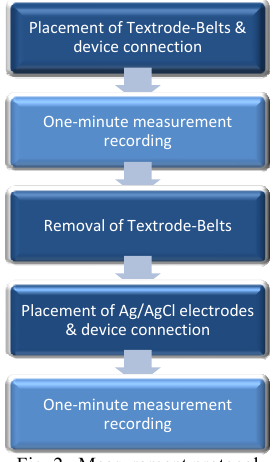
Placement of Textrode-Belts & device connection